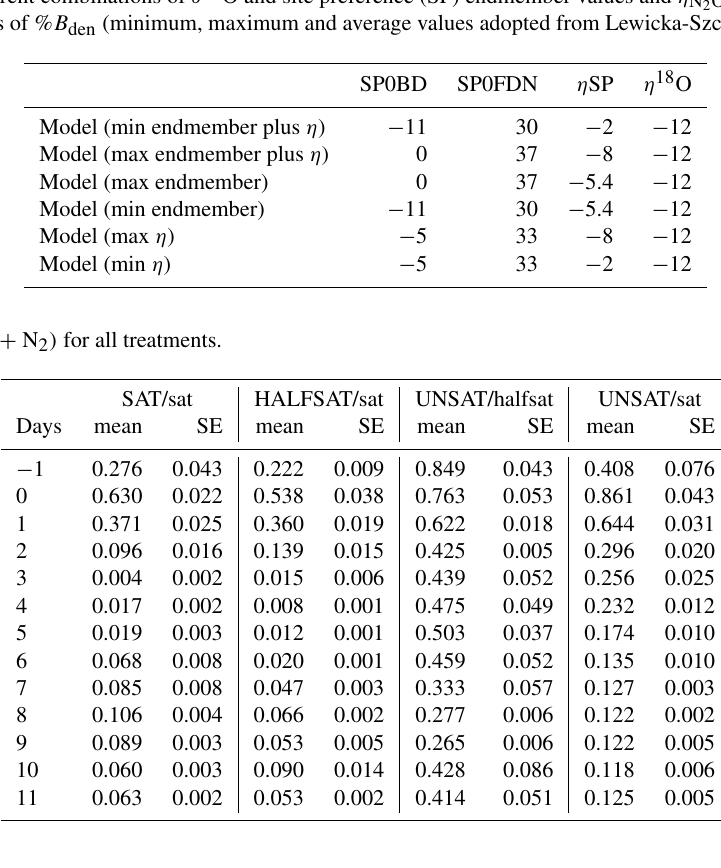
values to calculate maxi- 2 O − N 2